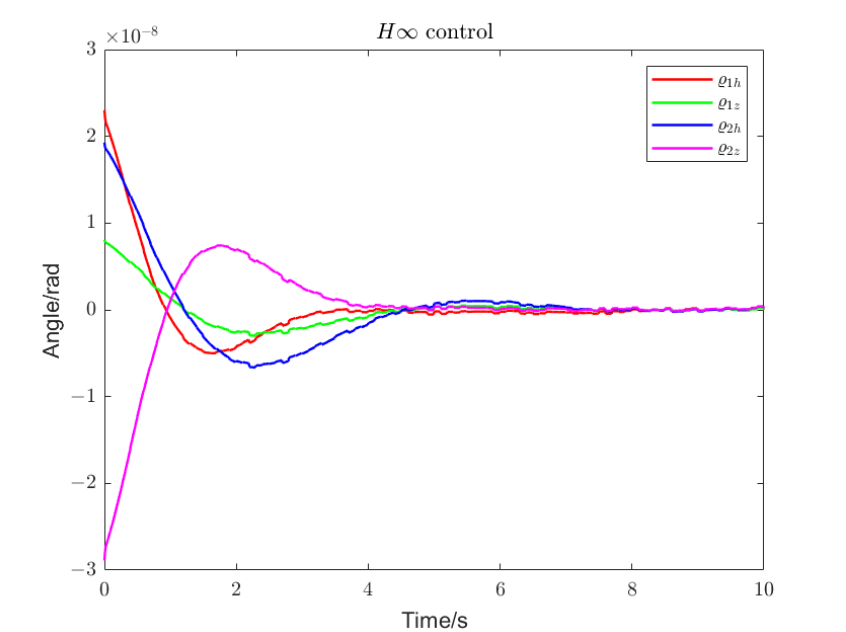
Figure 9. Pointing error of the telescope ( H ∞ control). With loop-shaping H ∞ control, the LOS attitude deviation of the pitch angle and the yaw angle under various disturbances can reach a stable state within 7 s.